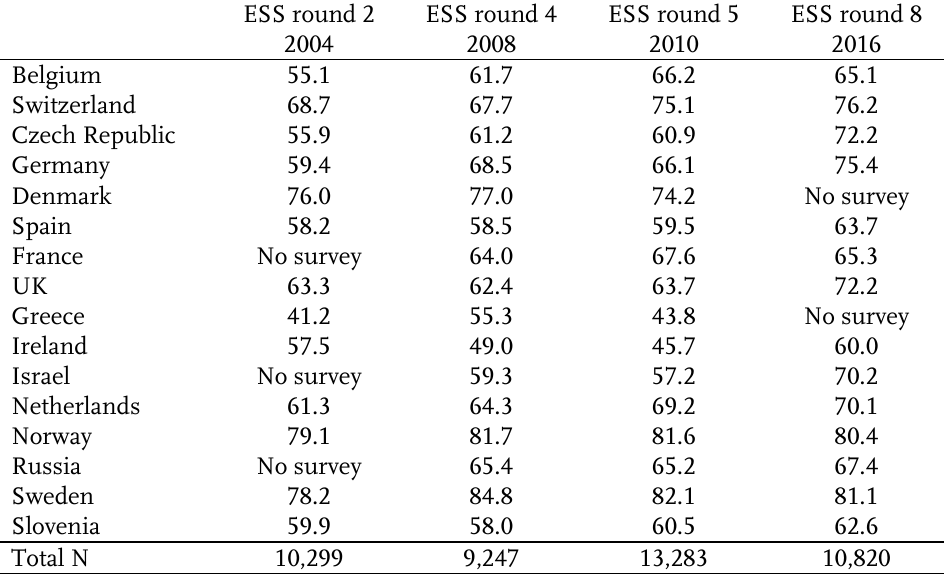
Table 1 : Share of women’s employment in countries across ESS